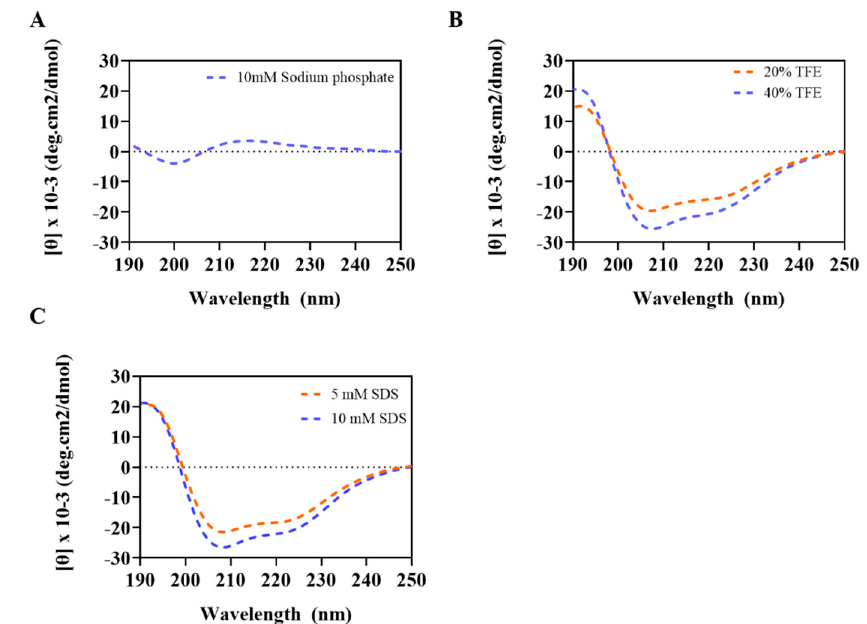
Figure 2. Circular dichroism (CD) spectra of Css54 measured in ( A ) 10 mM sodium phosphate, ( B ) TFE at 20% and 40%, and ( C ) SDS at 5 and 10 mM. Peptide concentration was fixed at 40 μ M.